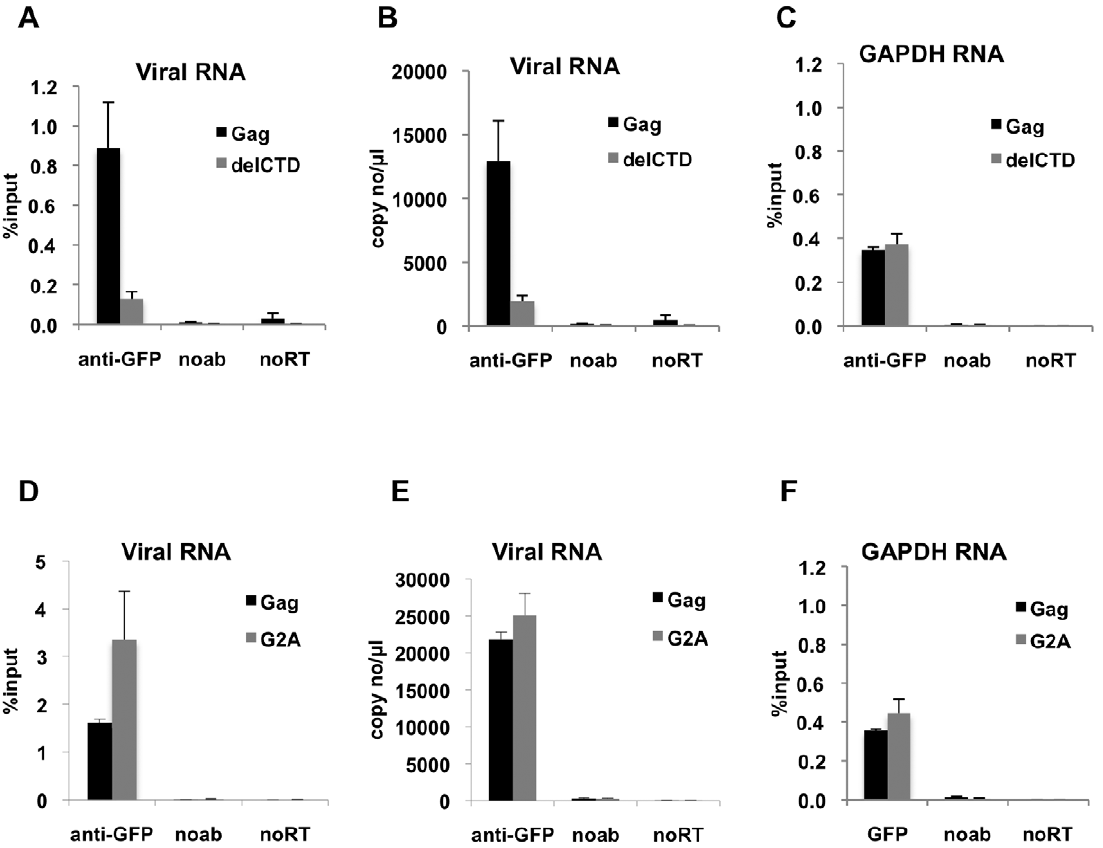
Figure 2. Interaction of Gag with HIV-1 genome is enhanced by an intact CA domain but not by Gag myristoylation. ( A-C ) V1B-MS2 viral RNA bound to either Gag-GFP (black bars) or Gag-delCTD-GFP (gray bars) was immunoprecipitated by anti-GFP antibodies from lysates of 293T cells. Immunoprecipitations without antibodies (noab) were included in parallel as controls. ( D-F ) V1B-MS2 viral RNA bound to either Gag-GFP (black bars) or Gag-G2A-GFP (gray bars) was immunoprecipitated by anti-GFP antibodies as in (A-C). Immunoprecipitated RNA was quantitated by qRT-PCR to detect viral RNA (A, B, D, E) or cellular GAPDH RNA (C, F) as described in Materials & Methods and is represented either as fraction of input material prior to immunoprecipitation (% input) or copies of DNA per m l of reverse transcribed template (copy no/ m l). Data represents the average of two independent experiments, where error bars indicate the range between the averages of two experiments. noRT= as explained in legend to Figure 1.